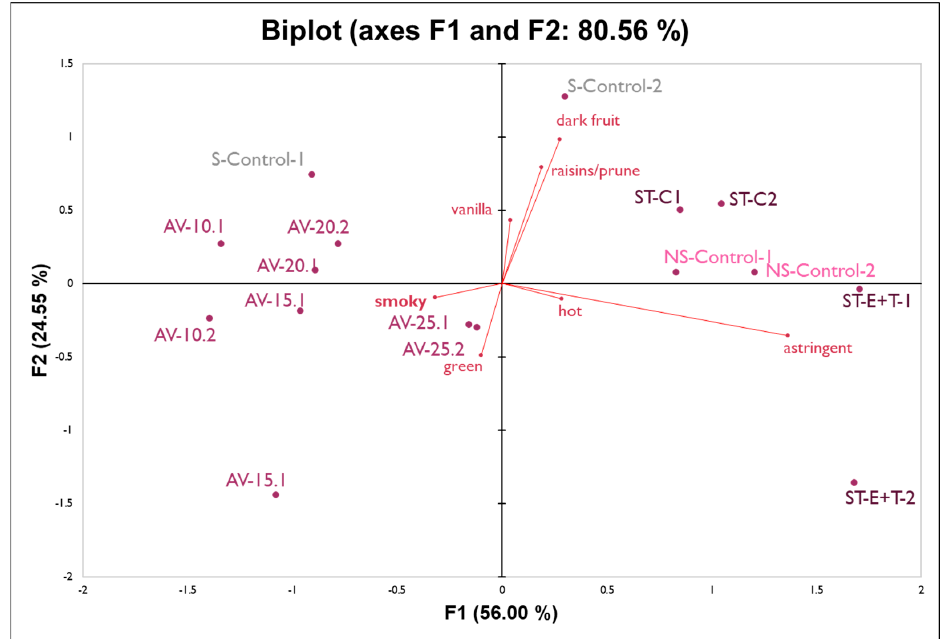
Figure 3. PCA biplot of all wine treatments from panel 2.